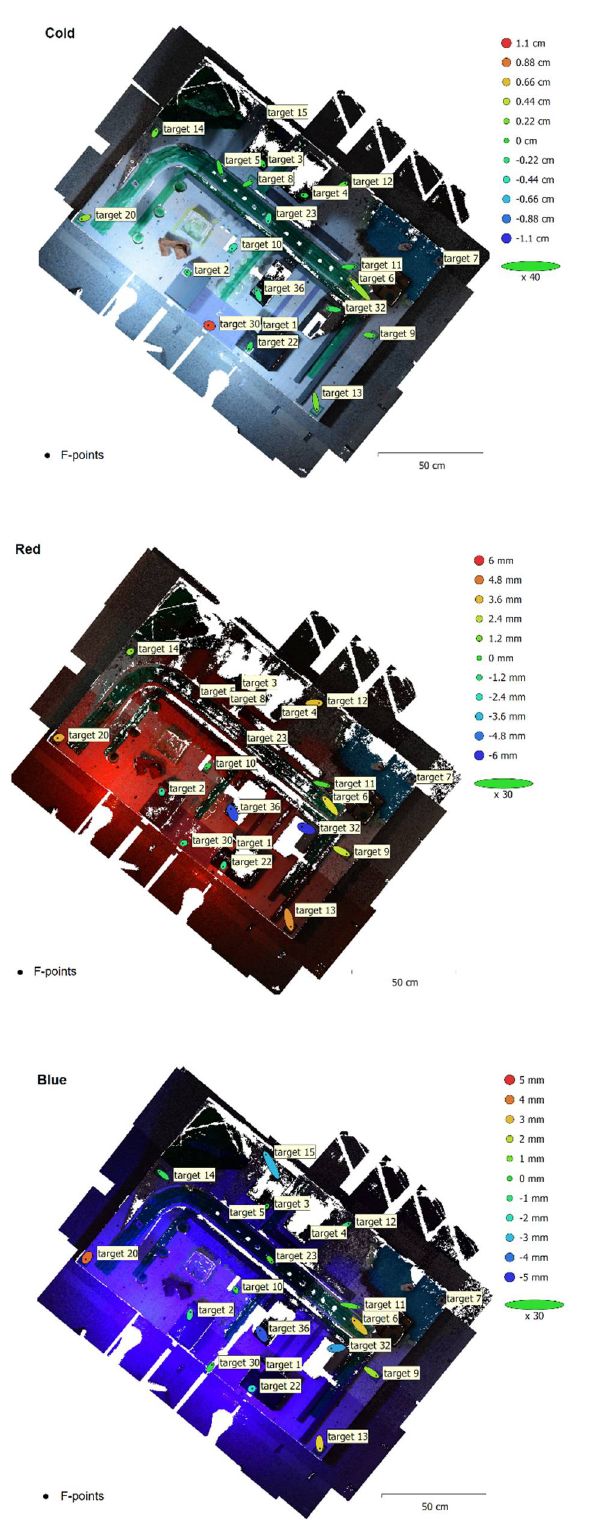
Figure 8. Views of concentrated point clouds for each of the studies.